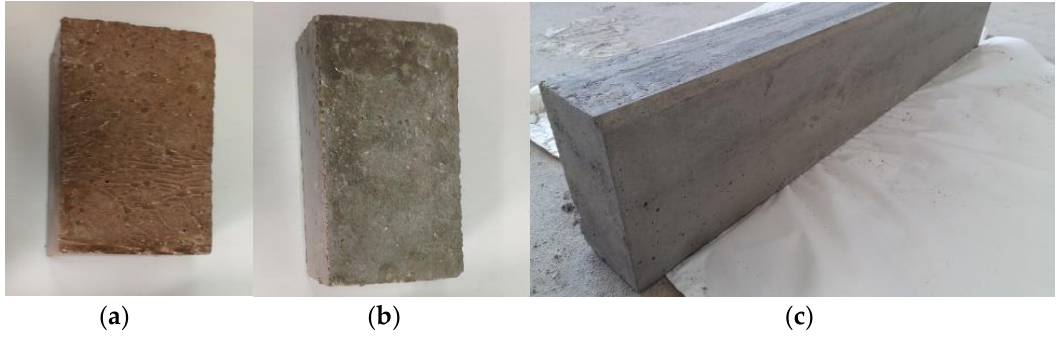
Figure 2. Precast units: ( a ) RACC paving block; ( b ) CC paving block; ( c ) CC kerb .